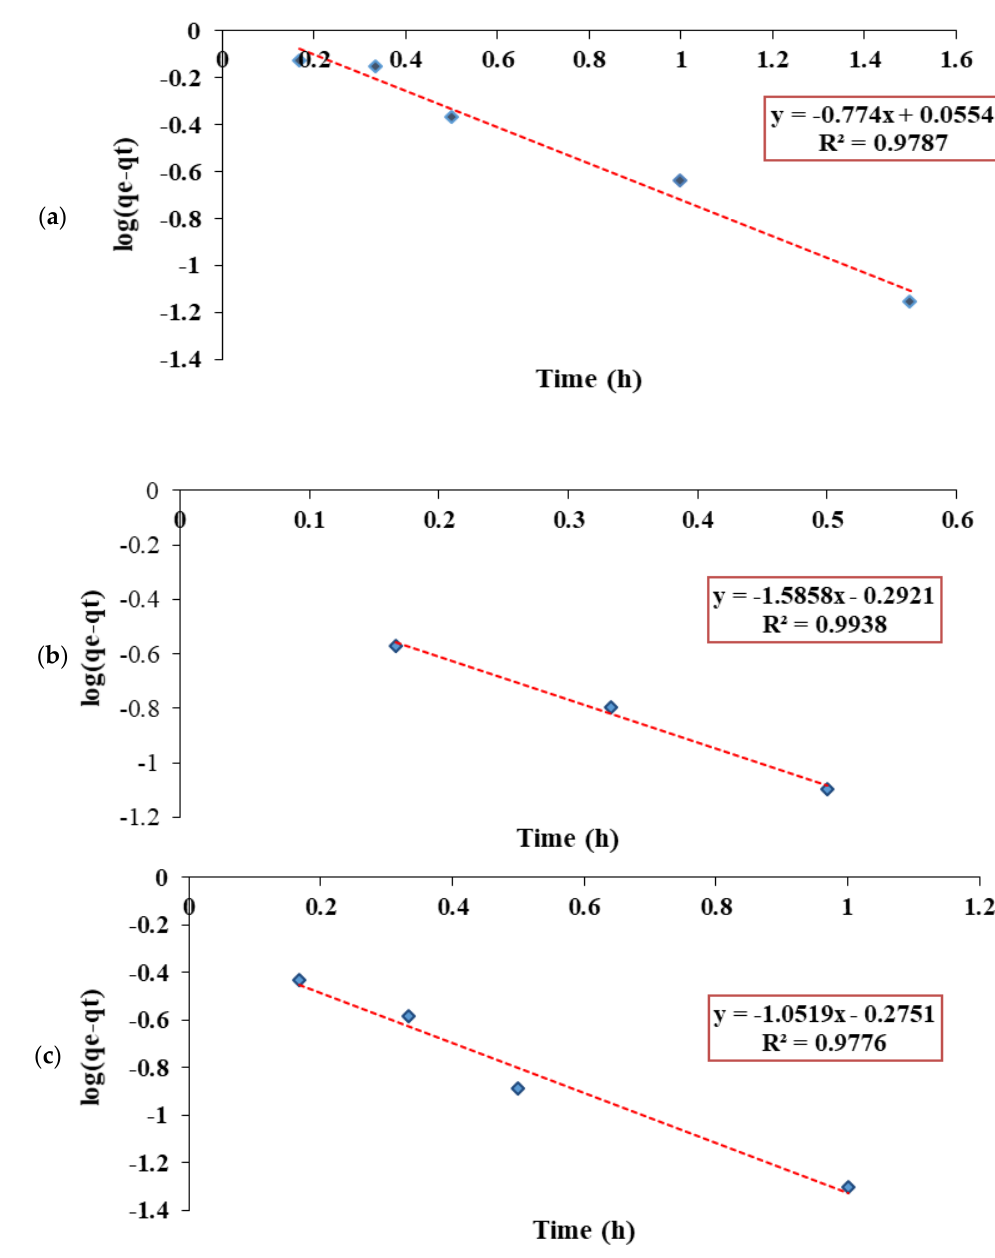
Figure 18. Linear plot of a pseudo-first-order kinetic model for the adsorption of calcium ions by ( a ) zeolite, ( b ) activated carbon, and ( c ) activated alumina.